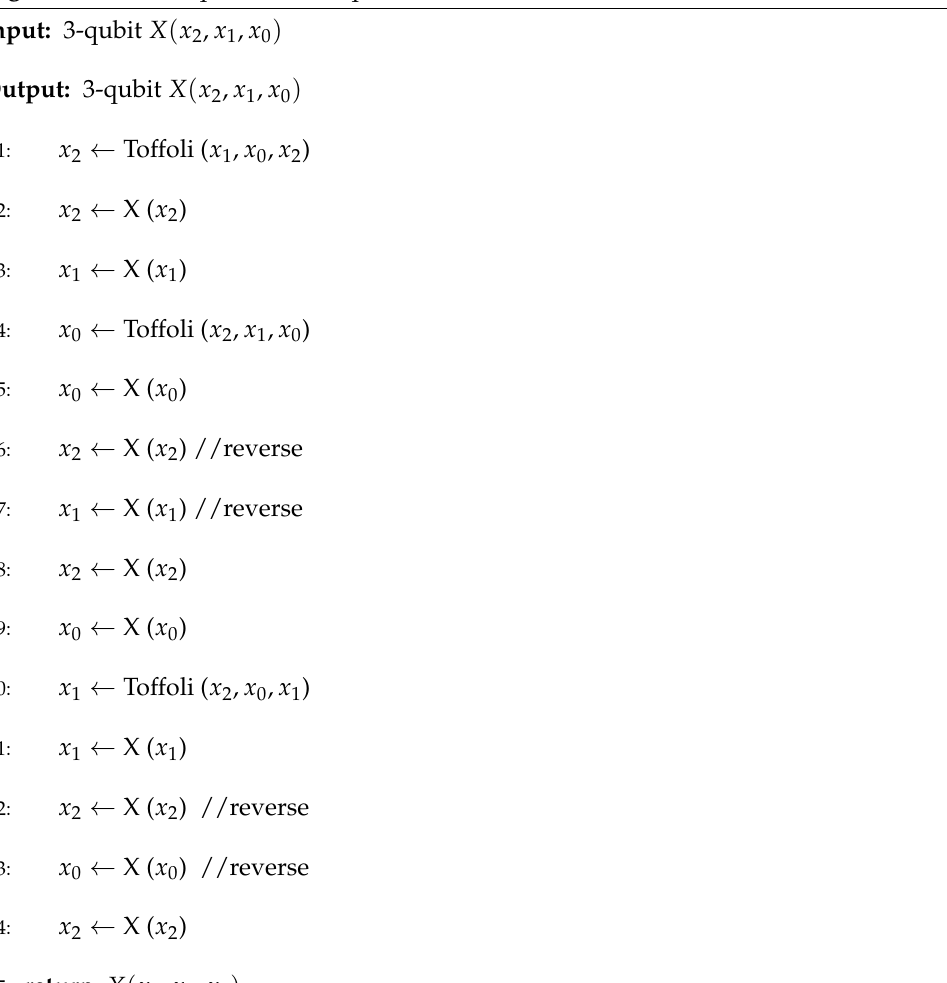
Algorithm 4 The 3-qubit Sbox in quantum